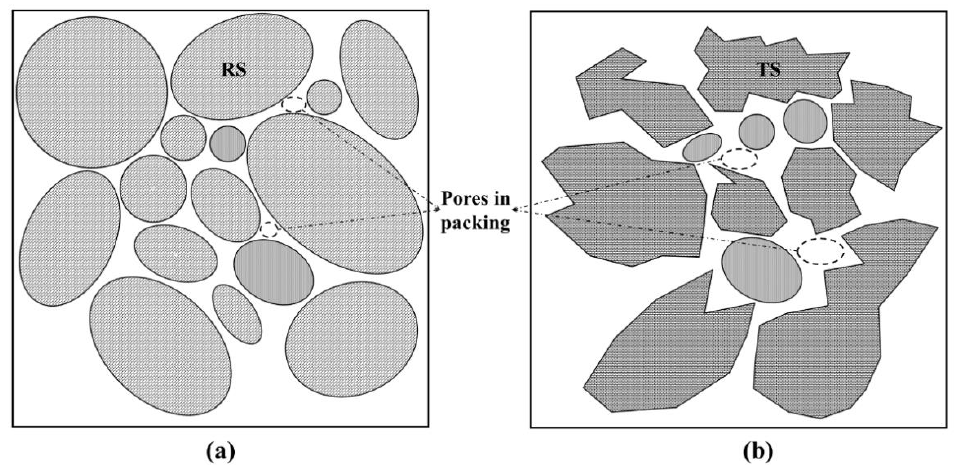
Figure 10. Pattern of particles packing model of two aggregates. ( a ) river sand ( b ) iron tailing sand.